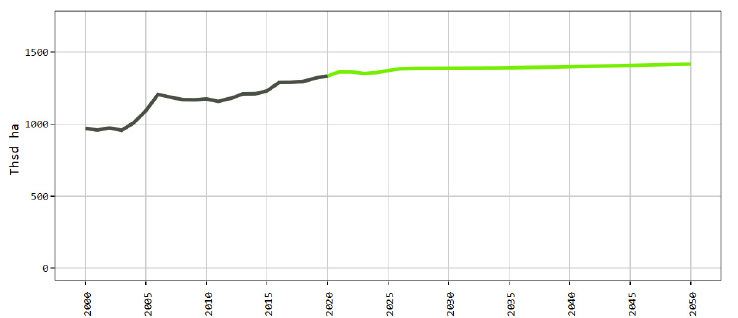
Figure 6. Arable land in 2000–2020, with a 2021–2050 projection for Latvia, in thousands of hectares [62].